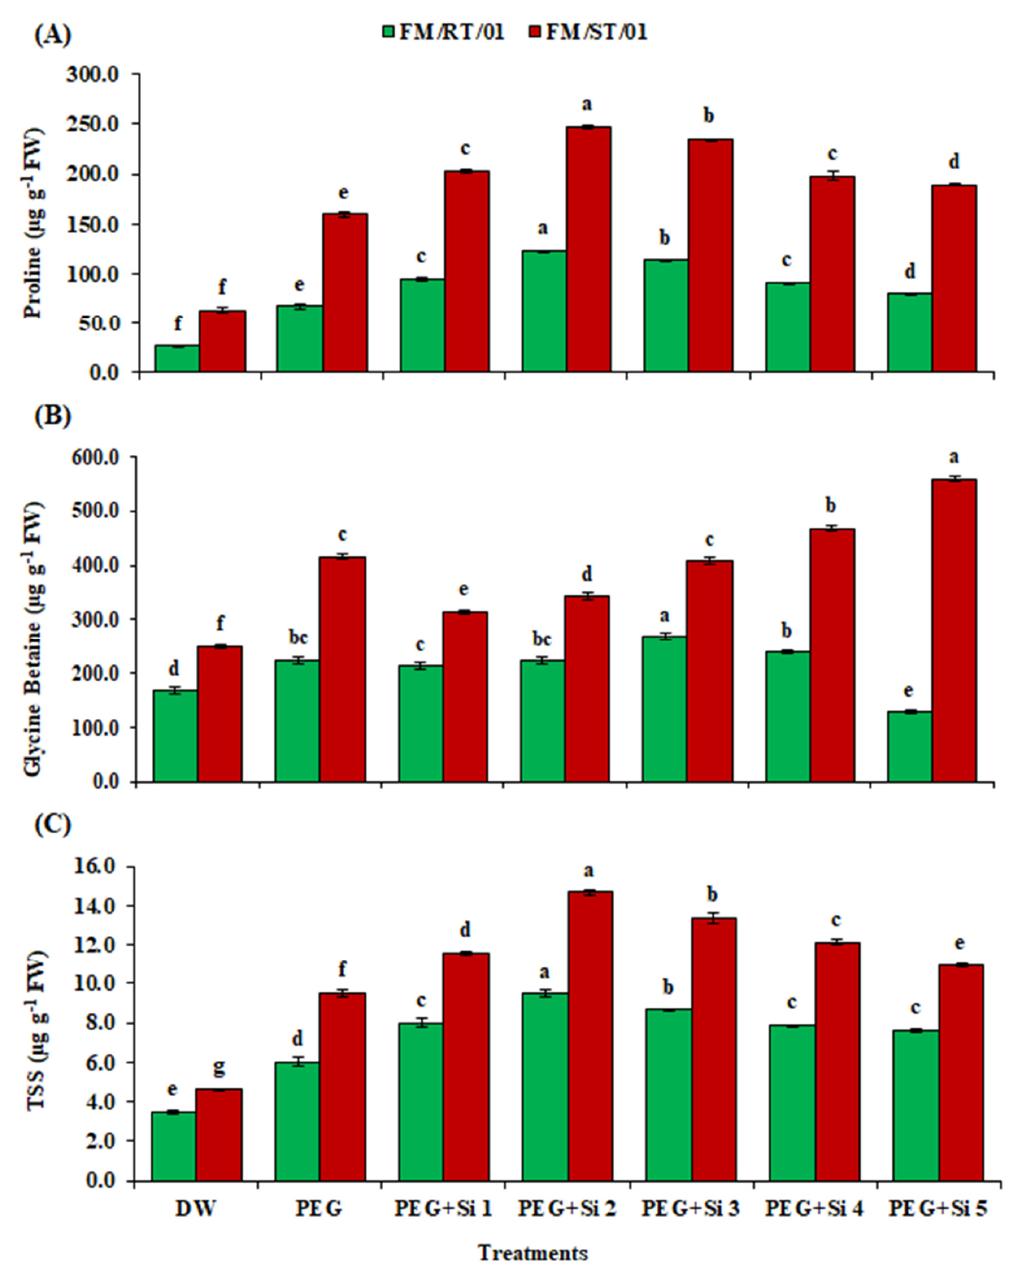
Figure 2 Effect of Si on osmolyte accumulation in seedlings of local finger millet landraces under PEG- 6000 induced osmotic stress A: Proline; B: Glycine Betaine; C: Total Soluble Sugars. Each value represents mean±SE. Values for each landrace with different alphabets are significantly different at p =0.05 as per Duncan’s Multiple Range Test. Si: Silicon; FM/RT/01: Osmotic stress sensitive landrace; FM/ST/01: Osmotic stress tolerant landrace; DW: Distilled water; PEG: Polyethylene glycol (15%); Si 1: Si 5 ppm; Si 2: Si 10 ppm; Si 3: Si 15 ppm; Si 4: Si 20 ppm and Si 5: Si 25 ppm; TSS: Total soluble